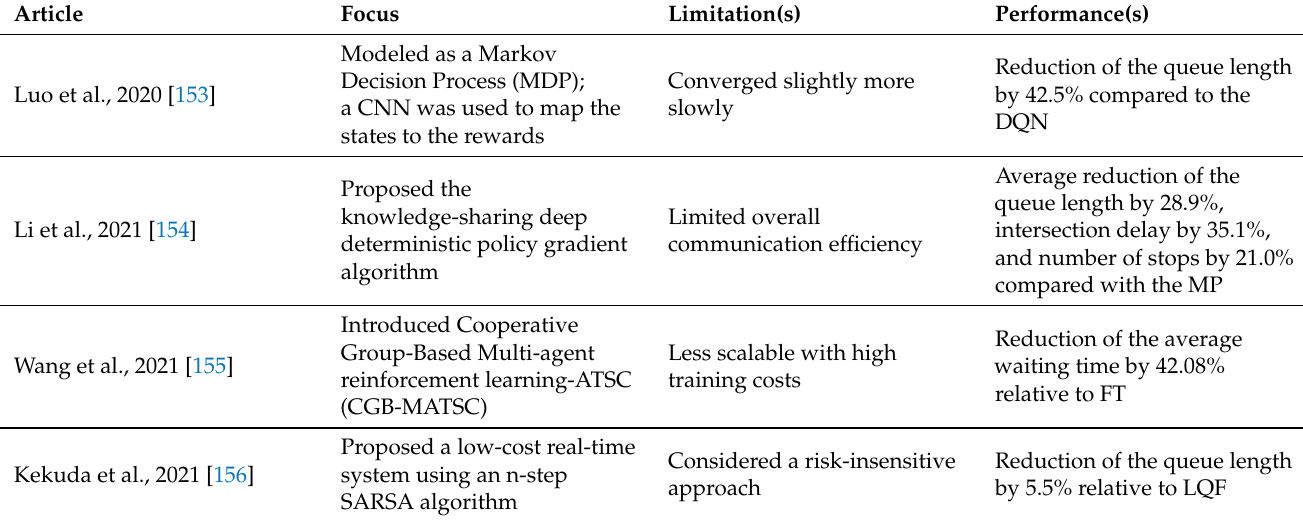
Table 26. Summary of the works found using